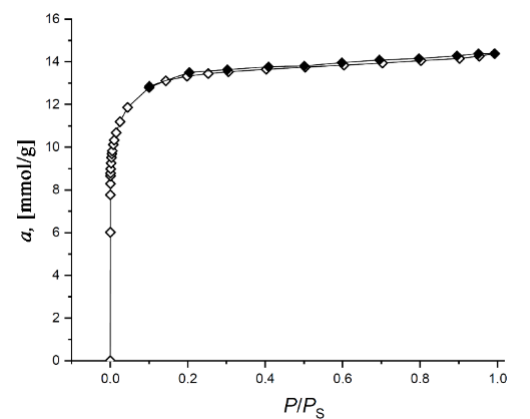
Figure 2. Isotherm of nitrogen adsorption (empty symbols)/desorption (dark symbols) on the SiC-AC carbon adsorbent measured at 77 K. Solid lines are the results of approximation by the Dubinin–Radushkevich (D-R) equation.